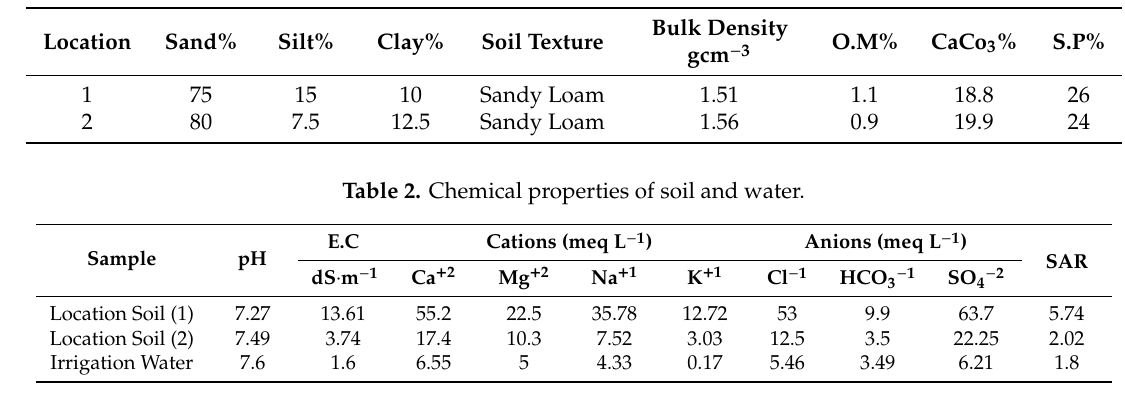
Table 1. Properties of soil and water.